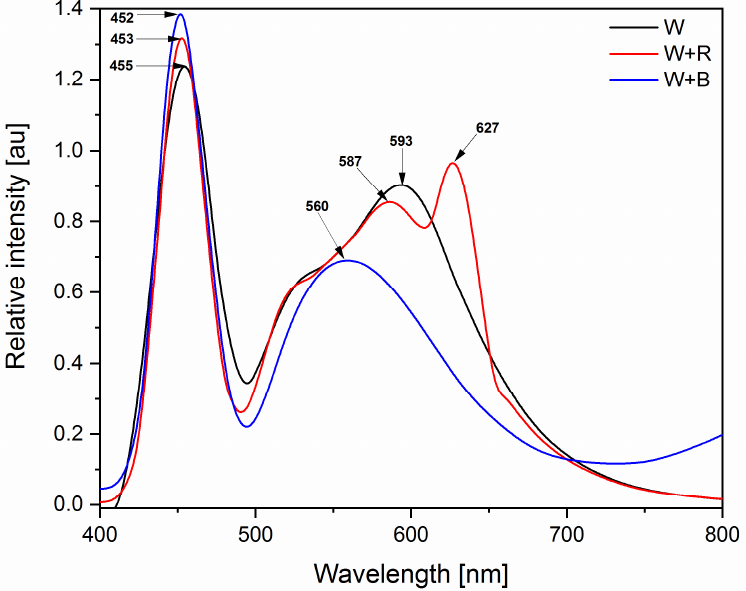
Figure 1. The spectral composition of the lamps for white light (W), white light with red light (W + R) and white light with blue light (W + B). The maxima for each of the lamps are marked on the spectrum.